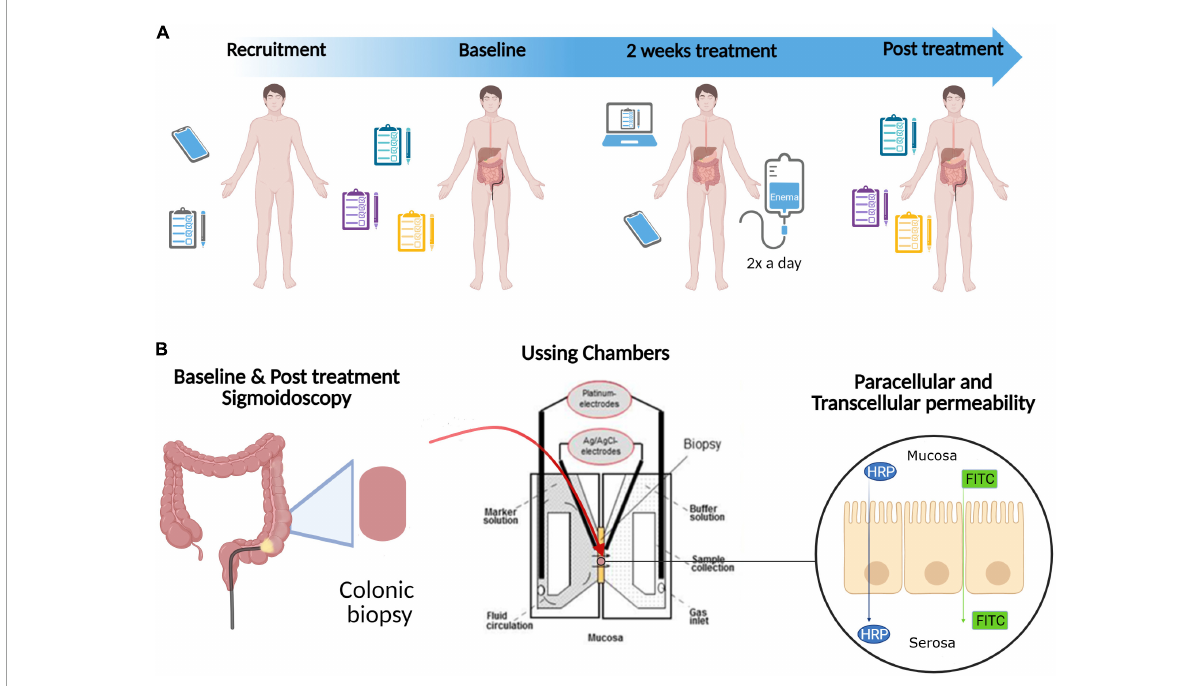
FIGURE1 Study design. (A) Potential participants were screened based on the inclusion and exclusion criteria ( Table 1 ) during telephone interviews ( Recruitment ). Eligible patients were then randomly allocated to one of two study arms: Referm R (cid:13) or placebo. The patients completed symptom questionnaires and underwent sigmoidoscopy with biopsies obtained from the distal colon at Baseline and after 14 days of intervention ( 2 weeks treatment ) with ReFerm R (cid:13) or placebo enema twice a day ( Post treatment ). During the 2 weeks treatment , the patients were given a check-up call by a principal investigator (OBe) twice per week and completed daily web questionnaire. (B) Biopsies obtained from the distal colon during Baseline and Post treatment sigmoidoscopy were mounted in Ussing chambers to determine paracellular [using fluorescein isothiocyanate (FITC)-dextran 4000] and transcellular [using horseradish peroxidase (HRP)] permeabilities of the intestinal mucosa. In addition, the direct effect of ReFerm R (cid:13) and placebo on paracellular and transcellular permeabilities in vitro were examined using the Caco-2 model (not shown in this figure). Created with